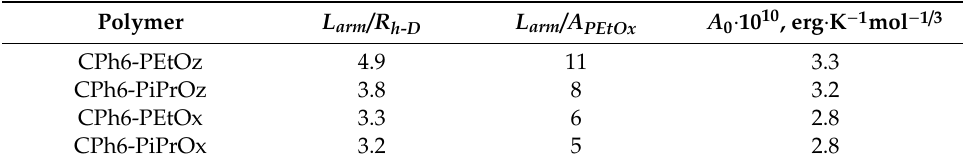
Table 3. Hydrodynamic characteristics of investigated polymer